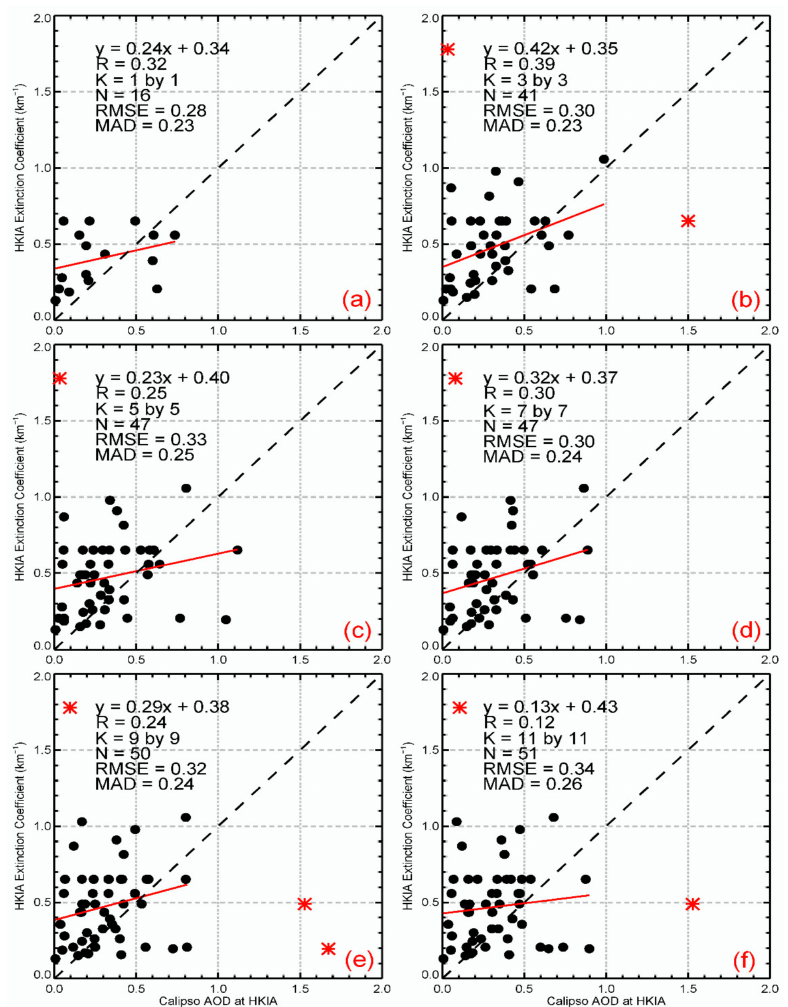
Figure 5. Like Figure 4, but at HKIA for kernel windows of ( a ) 1 by 1 ( b ) 3 by 3 ( c ) 5 by 5 ( d ) 7 by 7 ( e ) 9 by 9 and ( f ) 11 by